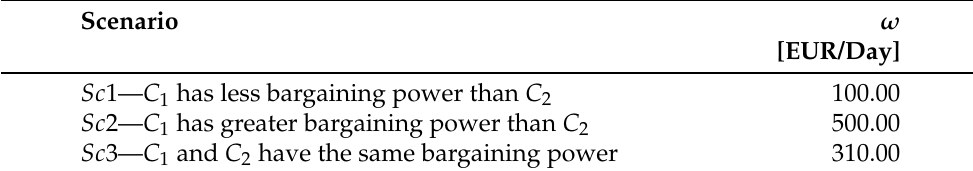
Figure 5. Framework for the operational level. Table 14. The three different scenarios for the operational